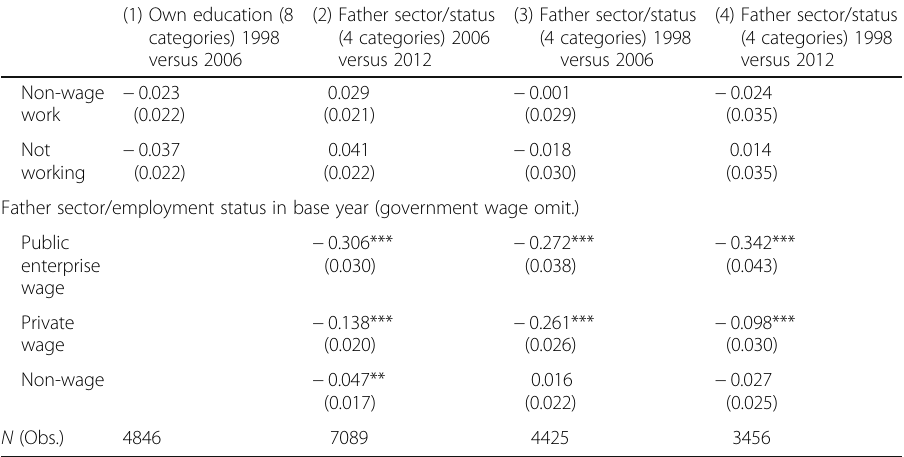
Table 2 Probit model marginal effects for the probability of alignment of reporting own education and father ’ s employment sector and status between the three contemporaneous points (1998, 2006, and 2012), individuals in base year (1998 or 2006) and present in the other waves, aged 30 – 54 in base year of the pair